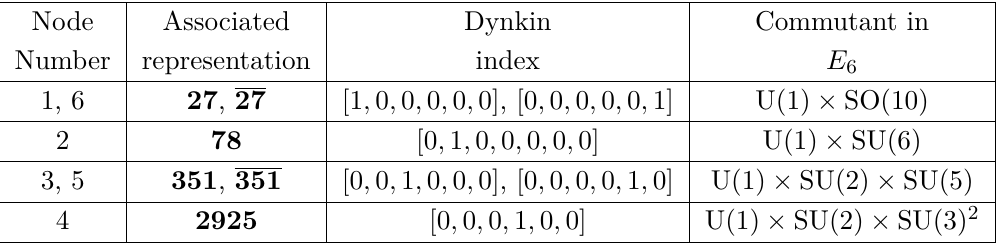
Table 3 . Representations associated with each node of the E 6 Dynkin diagram and the subgroup that they